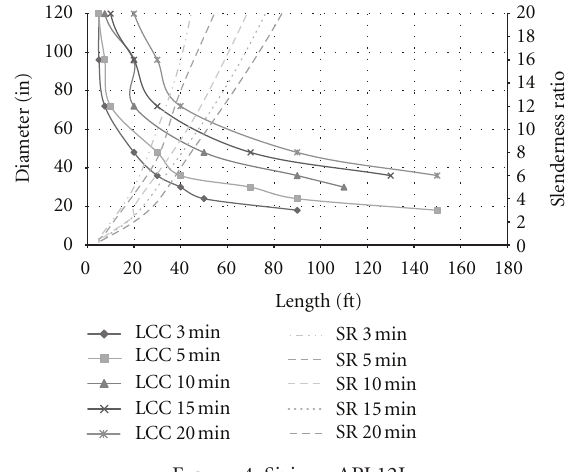
Figure 4: Sizing - API 12J.